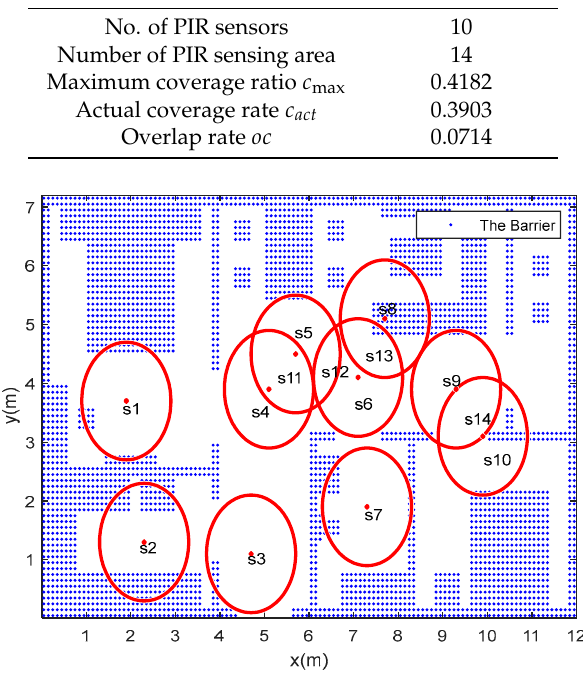
Figure 9. PIR deployment and sensing area.